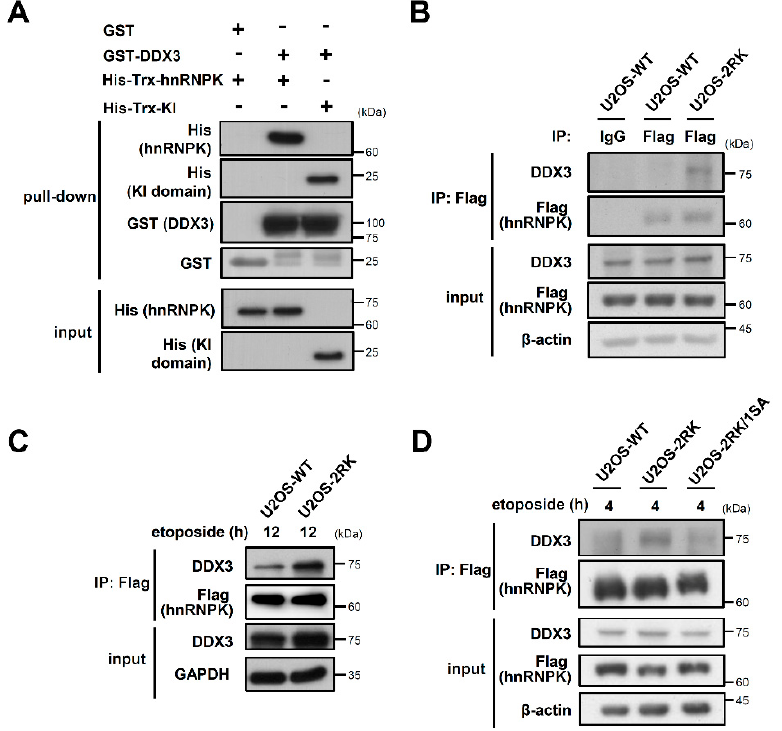
Figure 1. Loss of Arg296/299 methylation in hnRNPK promotes the DDX3–hnRNPK interaction in vivo upon DNA damage. ( A ) Recombinant hnRNPK or Trx-KI was incubated with GST-DDX3, followed by SDS-PAGE to determine the interaction between hnRNPK or KI and the DDX3 proteins. ( B ) Flag-tagged hnRNPK was precipitated from either U2OS-WT or U2OS-2RK cells using a Flag- specific antibody. Subsequent measurement of the precipitated DDX3 by hnRNPK was performed using a DDX3-specific antibody. ( C ) U2OS-WT cells and U2OS-2RK cells were first treated with etoposide (50 μ M), respectively, followed by the immunoprecipitation of Flag-hnRNPK. Subsequent measurement of the precipitated DDX3 was performed using DDX3-specific antibodies. ( D ) U2OS- WT, U2OS-2RK, and U2OS-2RK/1SA cells were first treated with etoposide (50 μ M) followed by the immunoprecipitation of Flag-hnRNPK. Subsequent measurement of the precipitated DDX3 by either wild-type hnRNPK or hnRNPK MD with or without the S302A mutation was performed using DDX3-specific antibodies.